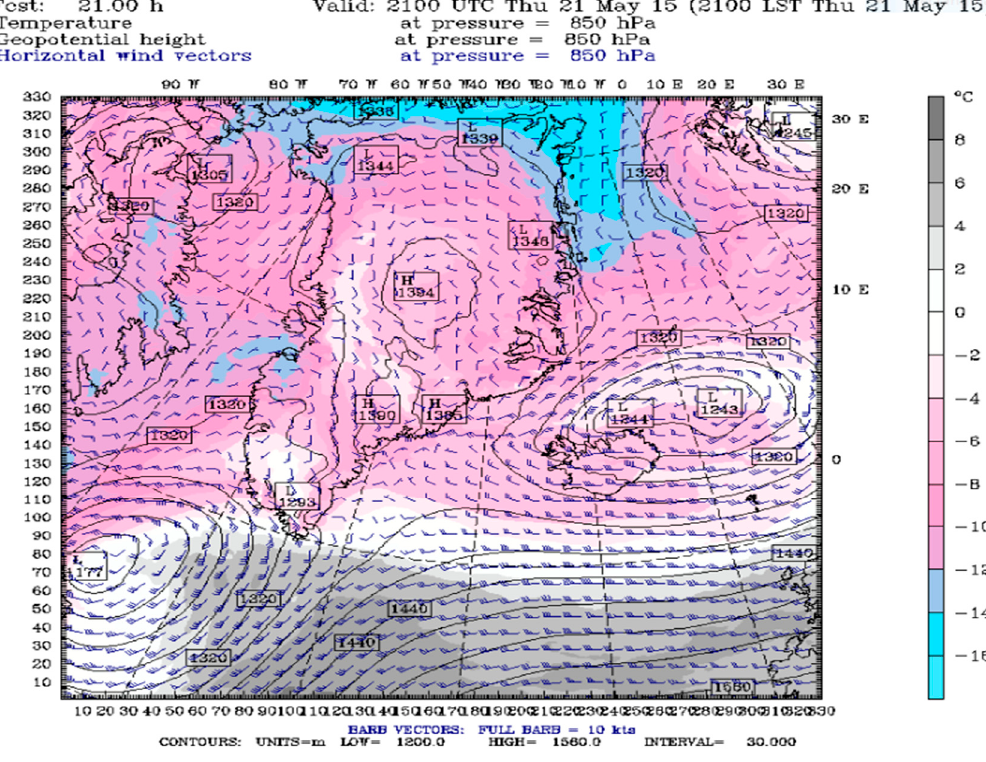
Figure 5. OSU Polar WRF 850 hPa forecast for 21Z on 21 May 2015.